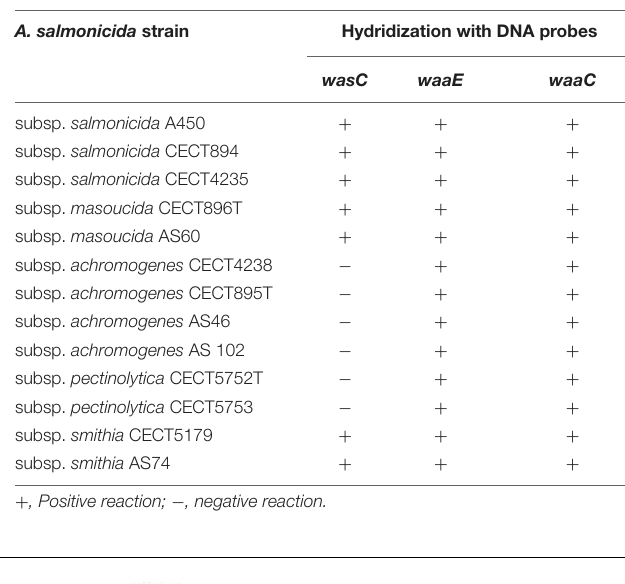
Frontiers in Microbiology |